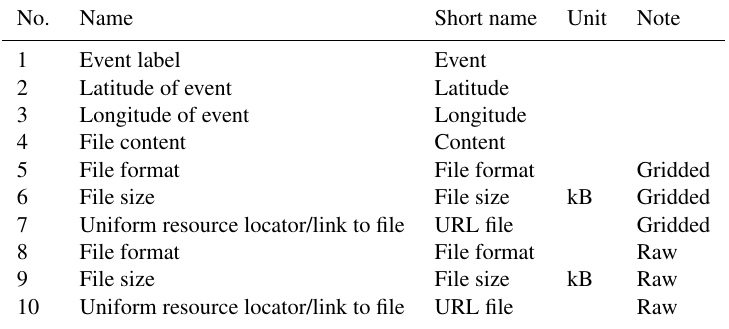
Table 10. Structure of the surface scan data set collection of raw point clouds and gridded subsets at PANGEA (Nield et al., 2020b). For each scan there is also an associated file containing a full 3D point cloud of the surface scan, with links embedded in the data table.